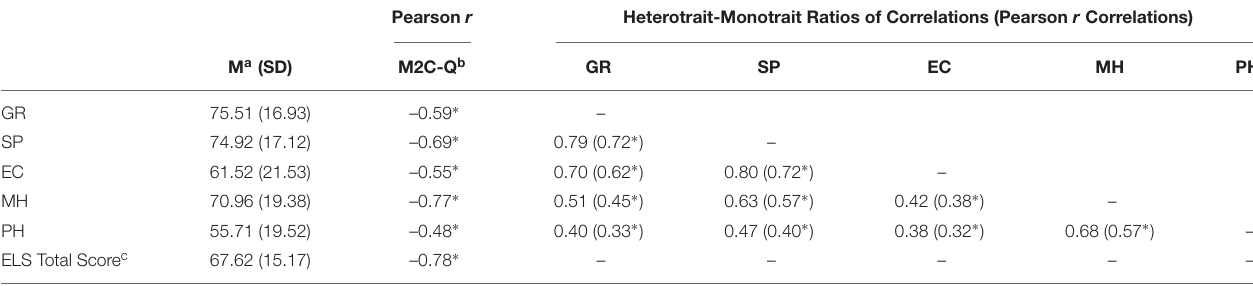
FIGURE 1 | Five-factor model of the Enriched Life Scale with factor loadings and factor covariances. Asterisks indicate statistical significance at p < 0.05. SP = sense of purpose, EC = engaged citizenship, PH = physical health, MH = mental health, GR = genuine relationships. TABLE 3 | Construct validity results for the five-factor ELS model ( n = 529). Pearson r Heterotrait-Monotrait Ratios of Correlations (Pearson r